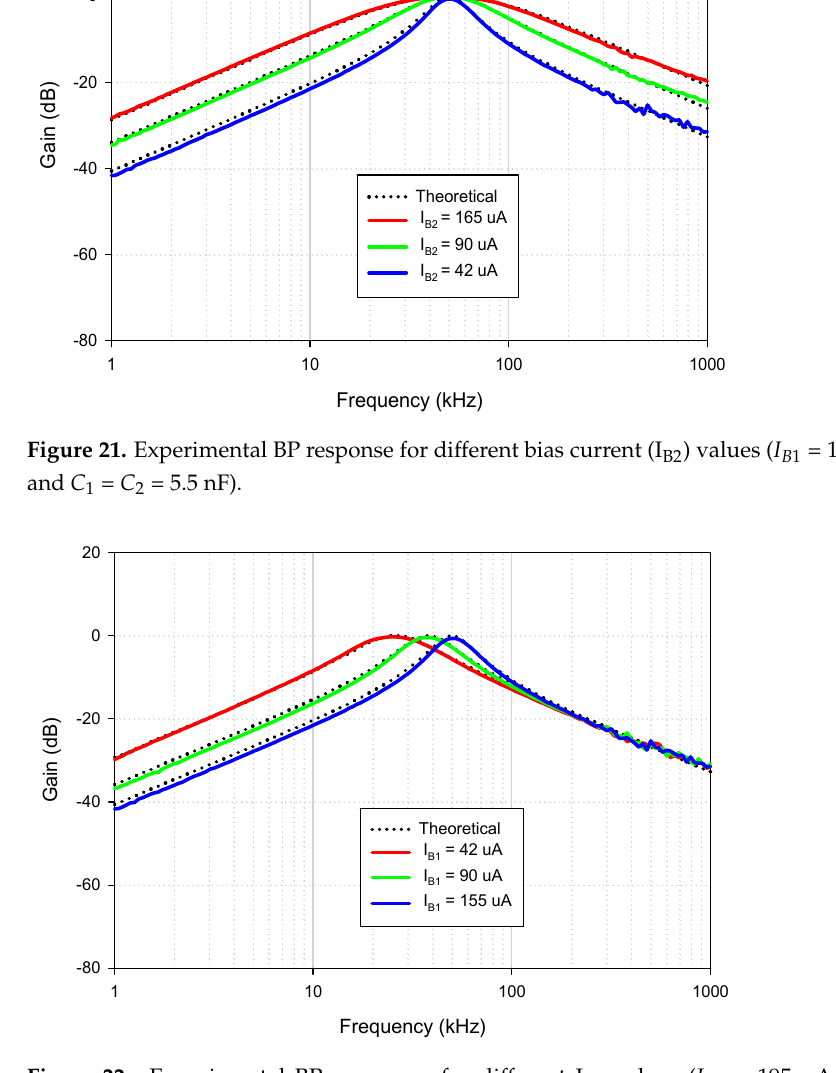
5.5 nF). C 1 = C 2 = 5.5